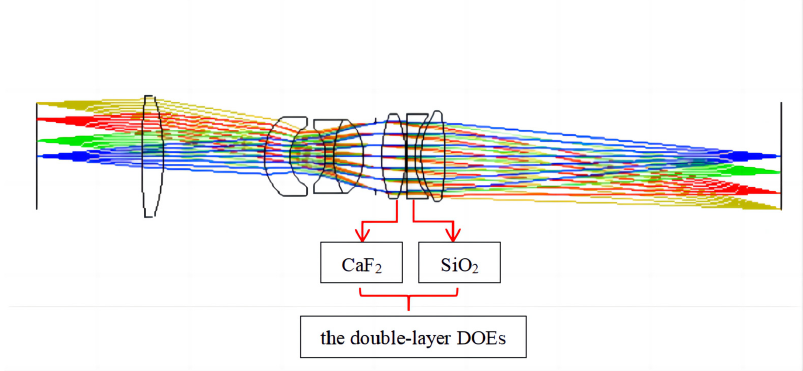
Figure 7. Layout of the refractive/diffractive hybrid lens system. Table 2. Lens data for the refractive/diffractive hybrid lens system.